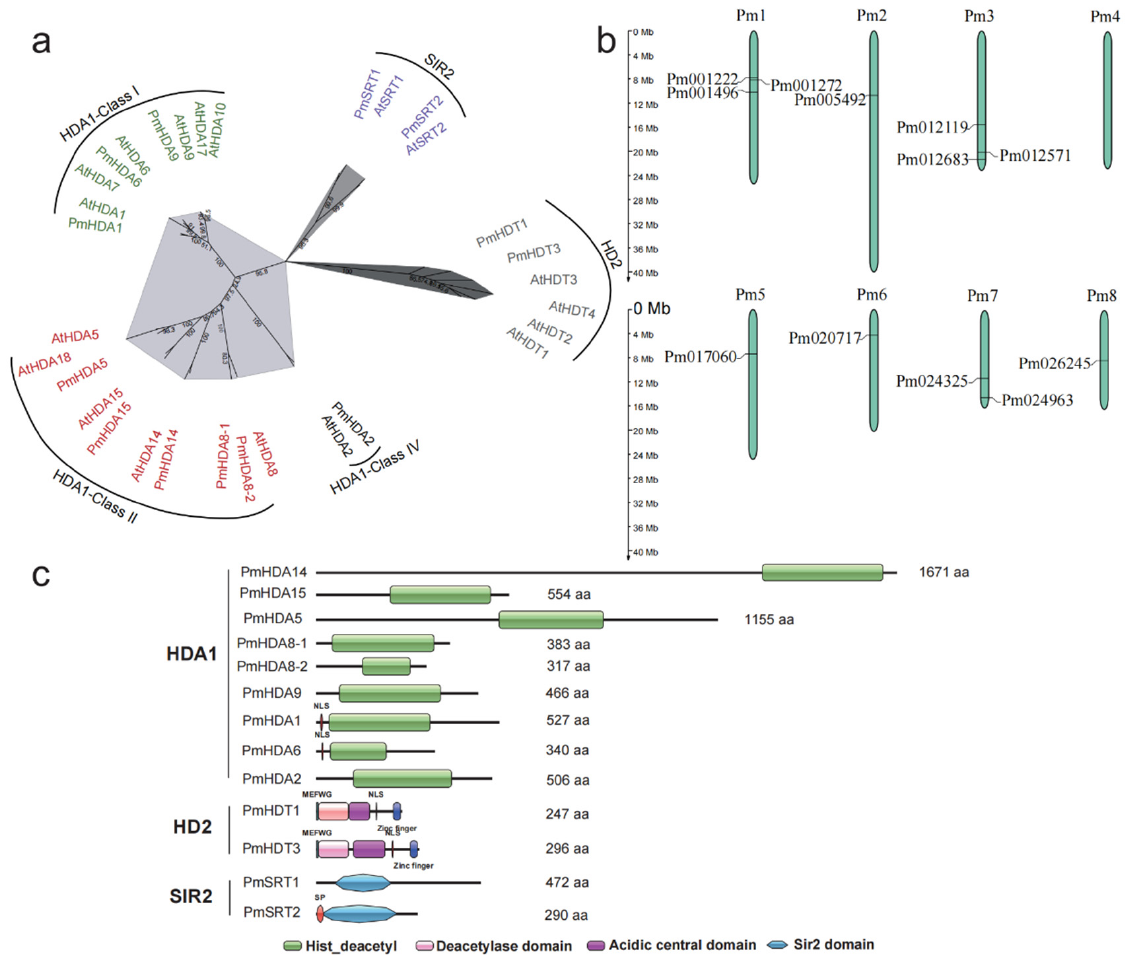
Figure 2. Characteristic analysis of PmHDACs. ( a ) Phylogenetic tree of HDACs in A. thaliana (At) and P. mume (Pm). The unrooted maximum likelihood tree was constructed by IQtree 2.1.3 using complete protein sequences with 1000 bootstraps. ( b ) Gene locations of PmHDACs on the mei chromosome; 12 out of 13 PmHDACs are localized on the 8 chromosomes, and 1 is on the scaffolds. The Pm1 to Pm8 represent eight mei chromosomes. ( c ) Conserved domains identified in PmHDACs proteins of three families.